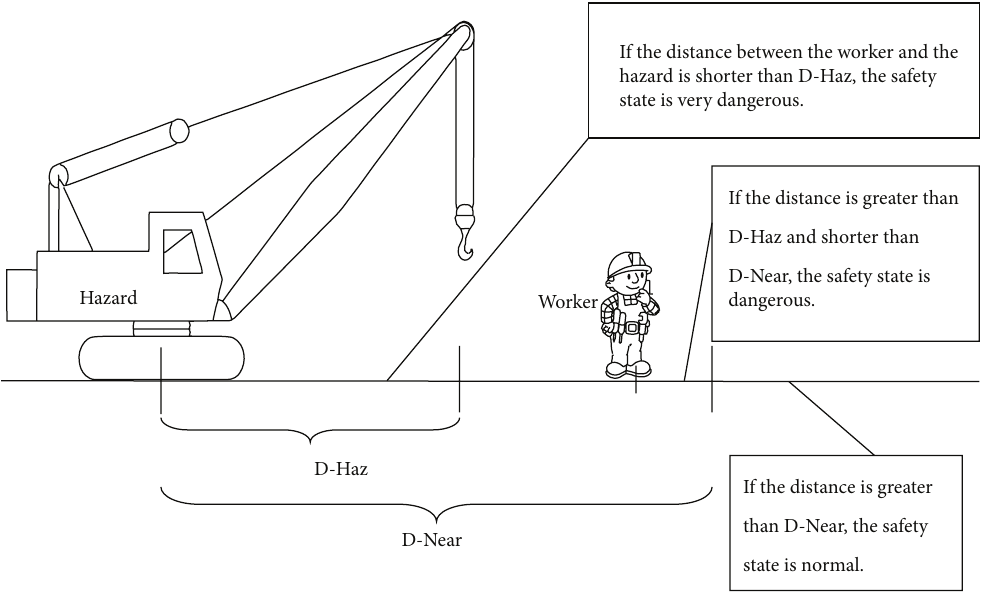
Figure 2: Definition of safety states associated with a crane.